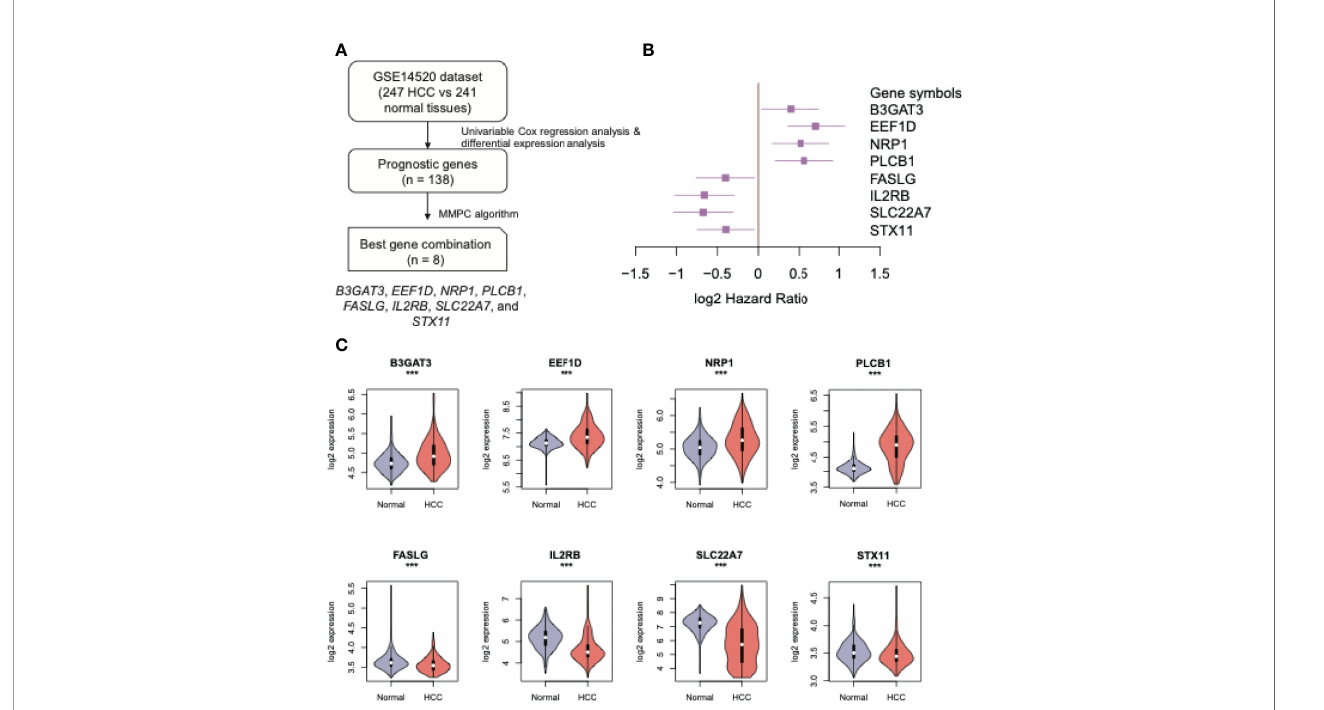
FIGURE 1 | The eight recurrence-related genes in HCC. (A) The work fl ow for the identi fi cation of the eight recurrence-related genes. (B) The forest plot displays the log2 (hazard ratios) (the boxes) and its 95% con fi dence intervals (the two ends) of the eight recurrence-related genes. (C) The expression patterns of the eight recurrence-related genes in HCC and adjacent normal tissues. The orange and purple colors represent the HCC and adjacent normal tissues, respectively. ***: P- value <